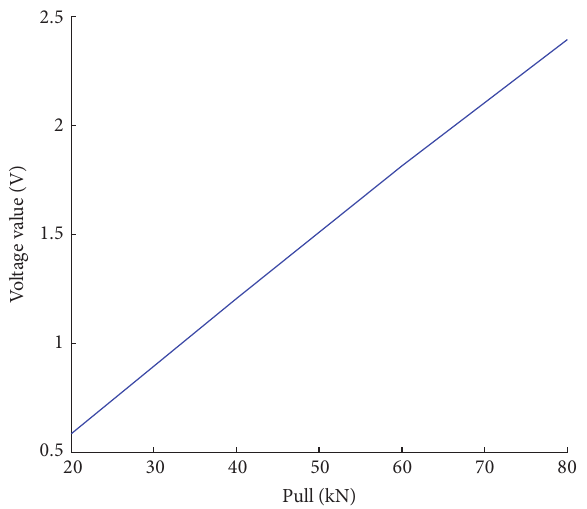
Figure 10: Calibration curve of the force sensor.